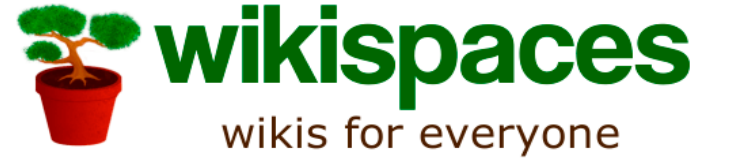
Figure 1. Wikispaces image (taken from the web